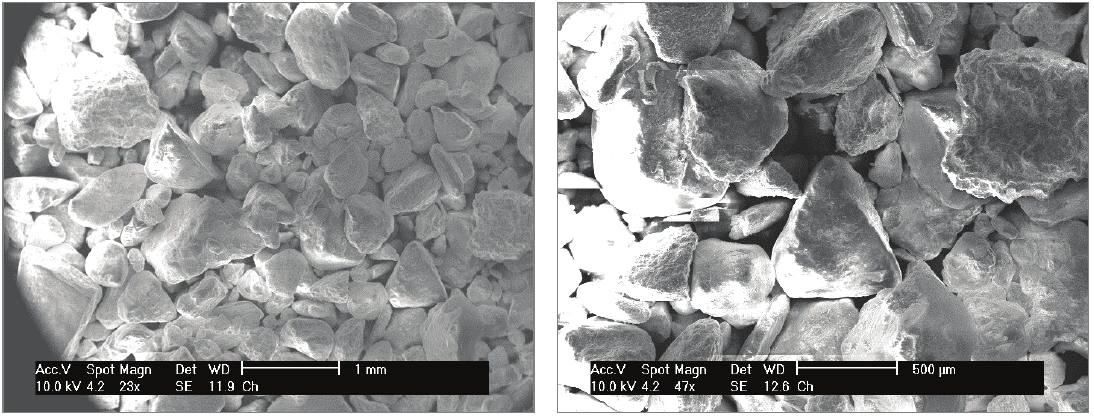
Fig. 3. Scanning electron micrograph images of the soil